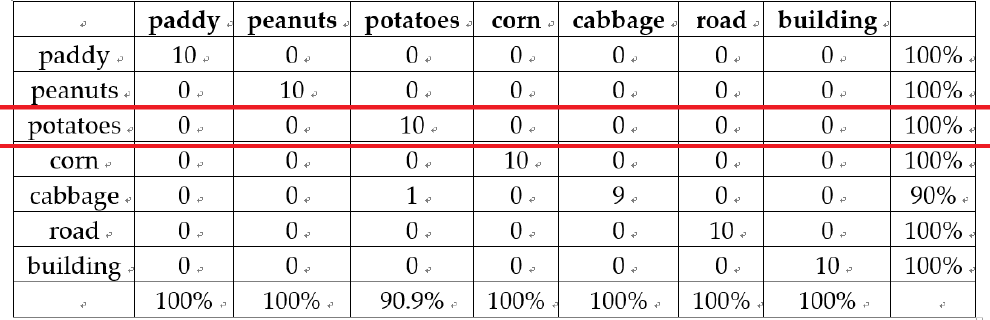
Table 6. Confusion matrix of CNN by PCA 24 epoch 30.